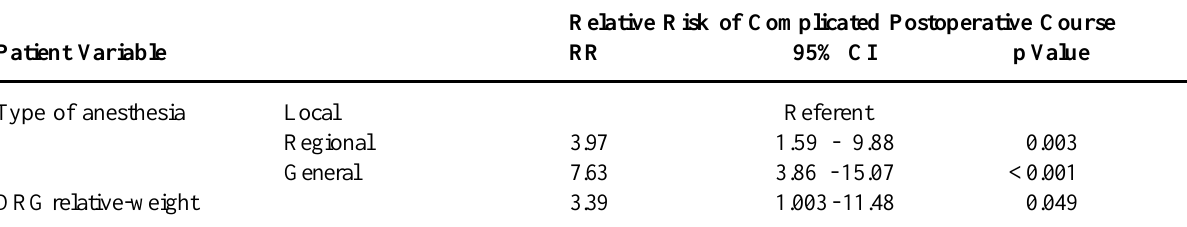
Table 5 – Significant results of the multivariate logistic regression model for independent predictors of complicated postoperative